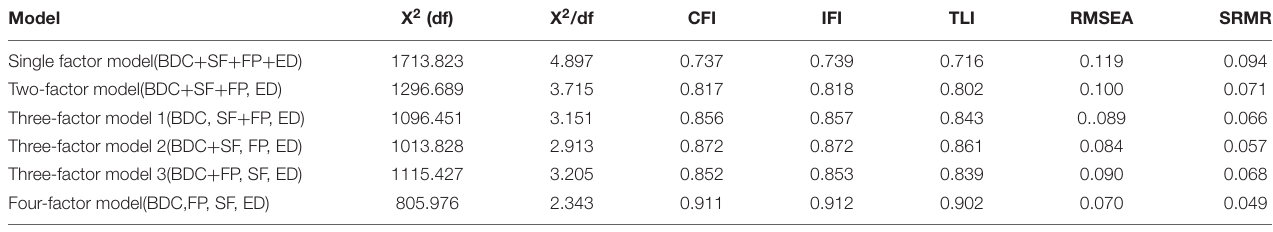
TABLE 4 | Correlation matrix of